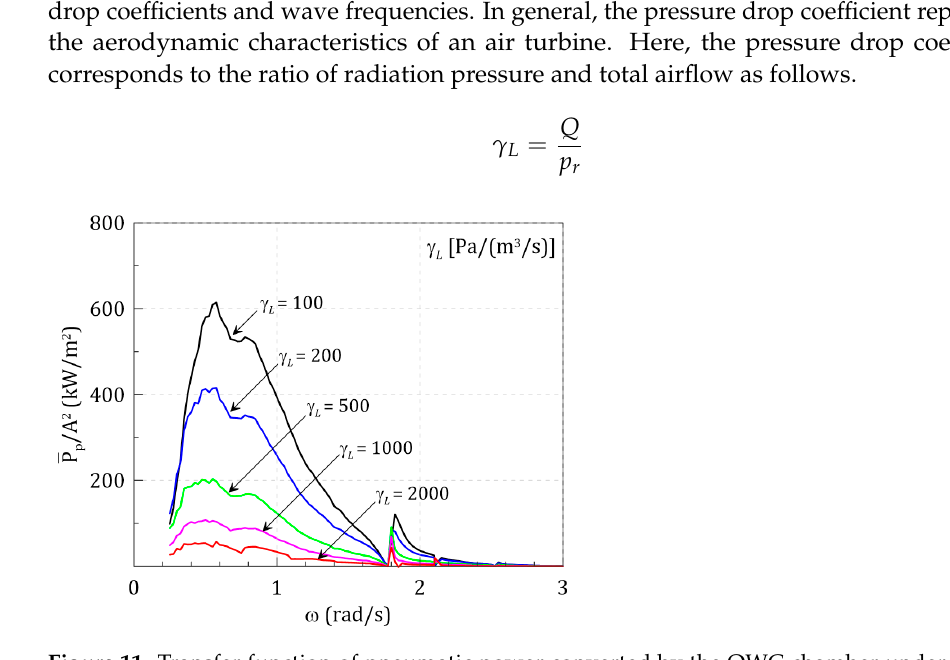
airflow; ( b ) pneumatic power.